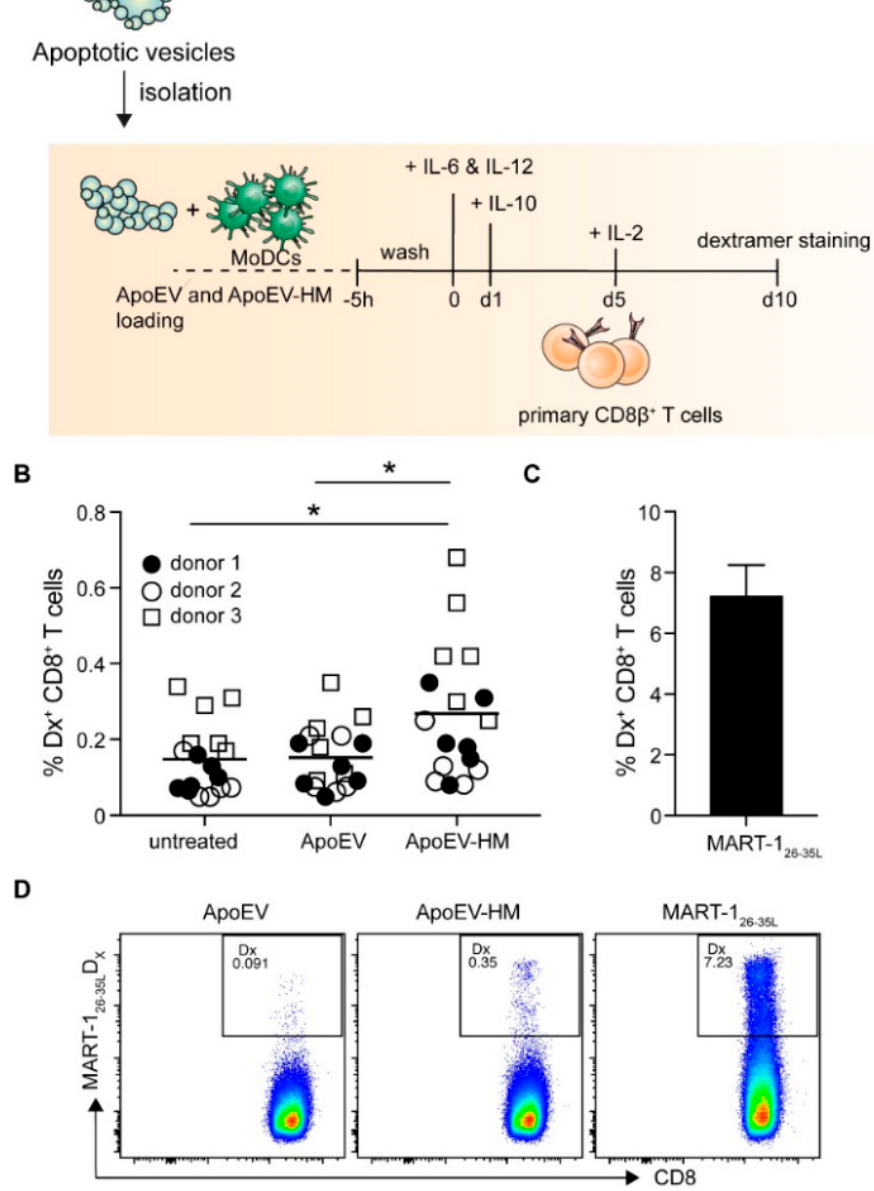
Figure 5. Glycan modification of ApoEVs (ApoEVs-HM) results in priming and expansion of MART-1-specific CD8 + T cells. ( A ) Protocol of priming and expansion of MART-1-specific CD8 + T cells. ( B ) MoDCs were loaded with the different vesicles in the presence of LPS. For the first and third donor six, and for the second donor five separate cultures were evaluated for each condition. Frequencies of MART-1 26–35L -dextramer + -CD8 + T cells were analyzed 10 days after induction. Combined data of three donors is shown as percentage of MART-1 26–35L -dextramer + -CD8 + T cells. Data were analyzed by one-way ANOVA with Tukey post-hoc test, * p < 0.05. ( C ) Frequencies of MART-1 26–35L Dx + CD8 + T cells present in the control cultures using the short MART-1 26–35L peptide. Data is shown as mean + SD of donor 1. ( D ) Representative flow cytometry plots of MART-1 26–35L - Dx + CD8 + T induced by ApoEV-, ApoEV-HM-, or short peptide (control)-loaded moDCs.